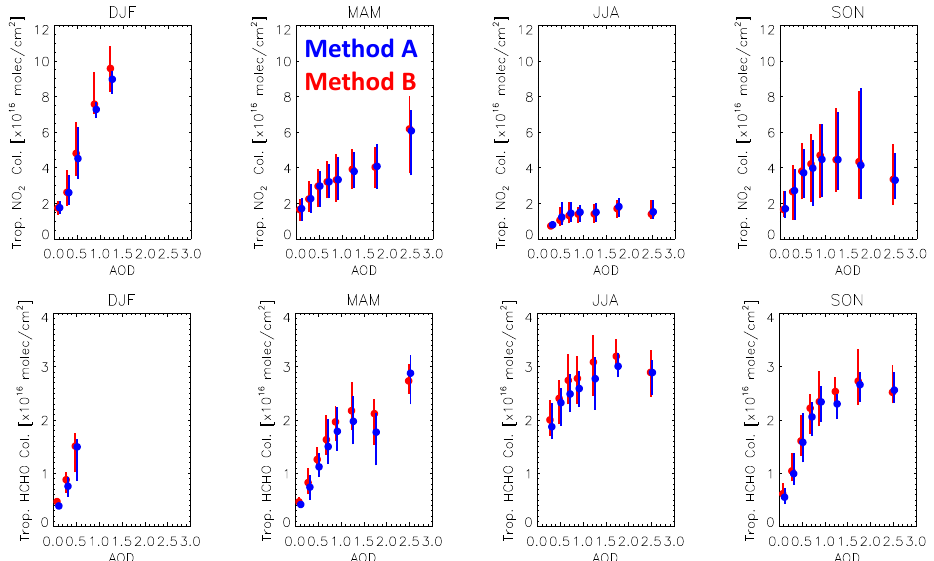
Figure 11. Median values of the tropospheric NO 2 column (upper row) and HCHO column (bottom row) for a range of AOD bins, specified per season.